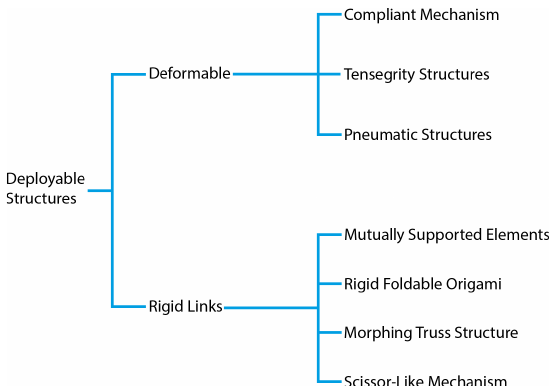
Figure 11: Classification by Del Grosso and Basso from